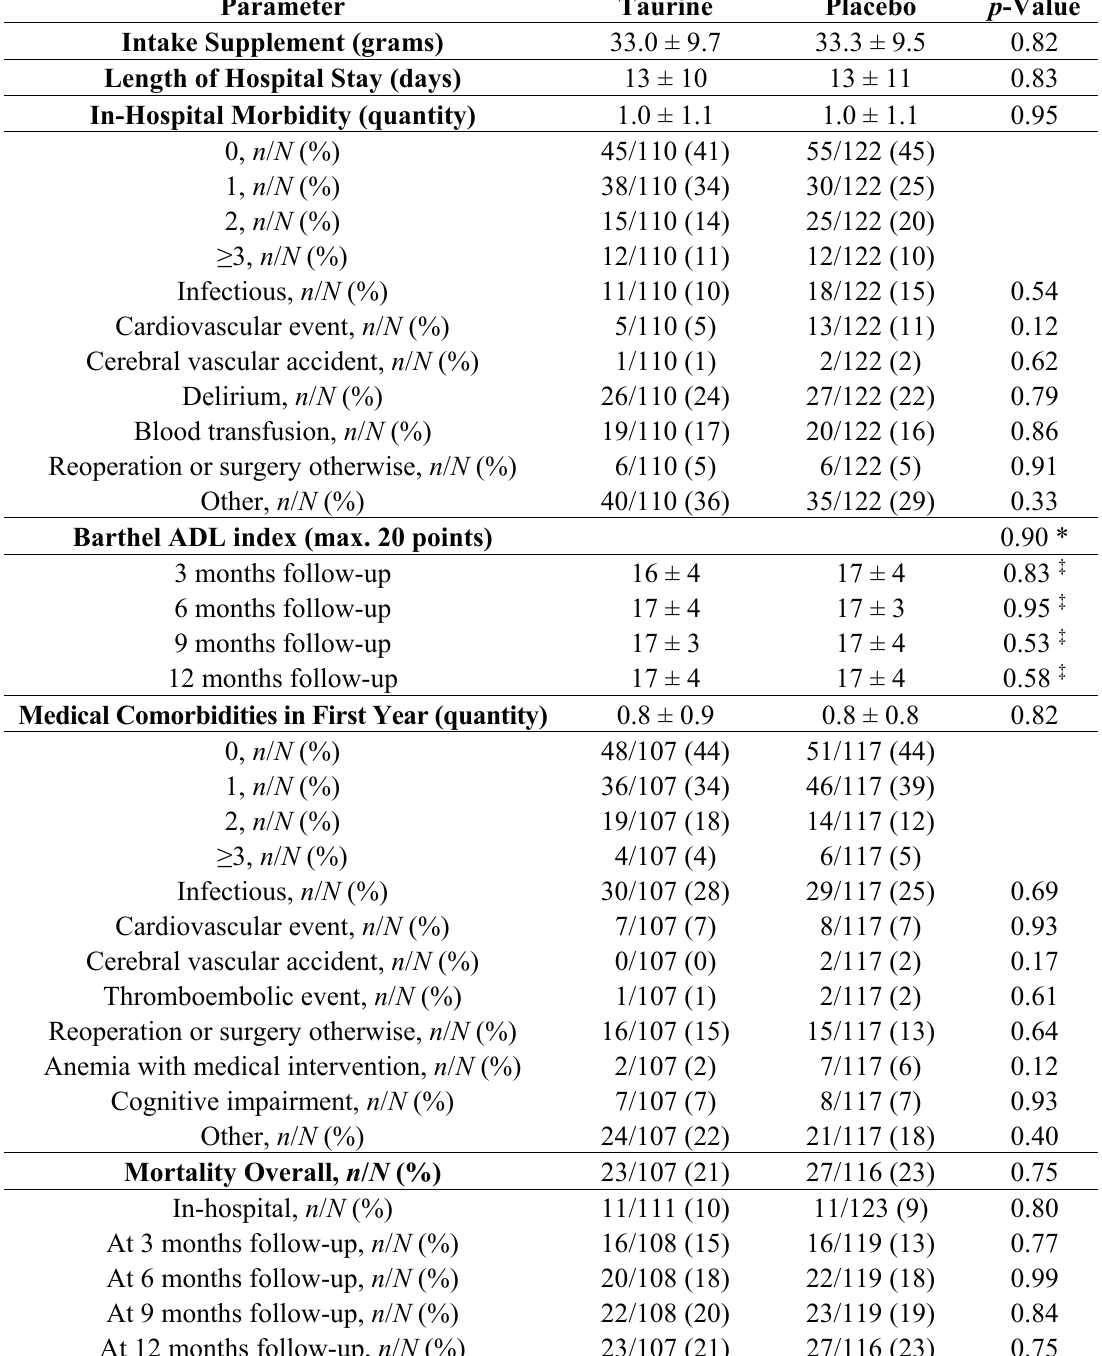
Table 4. Outcome